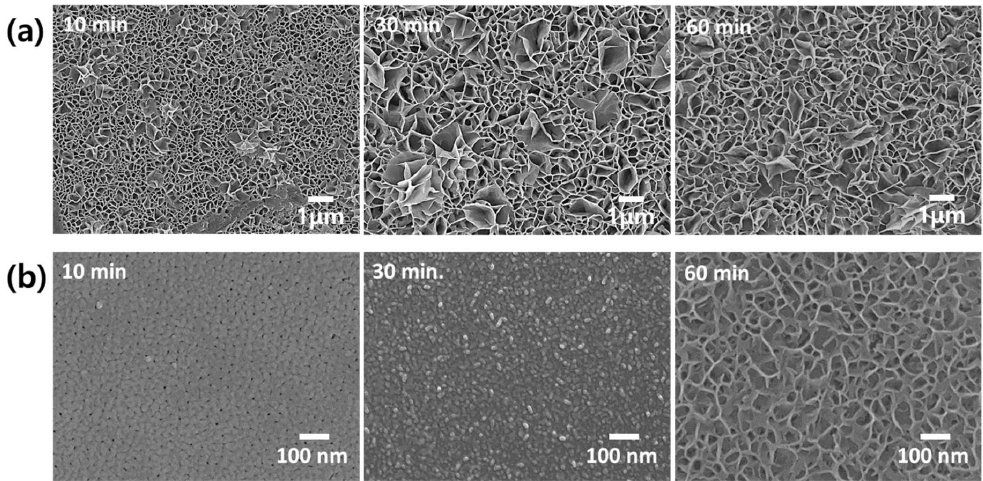
Figure 1. ( a ) SEM images and ( b ) potentiodynamic polarization curve (in 3.5 wt.% NaCl solution) of anodized aluminum alloy 6061.